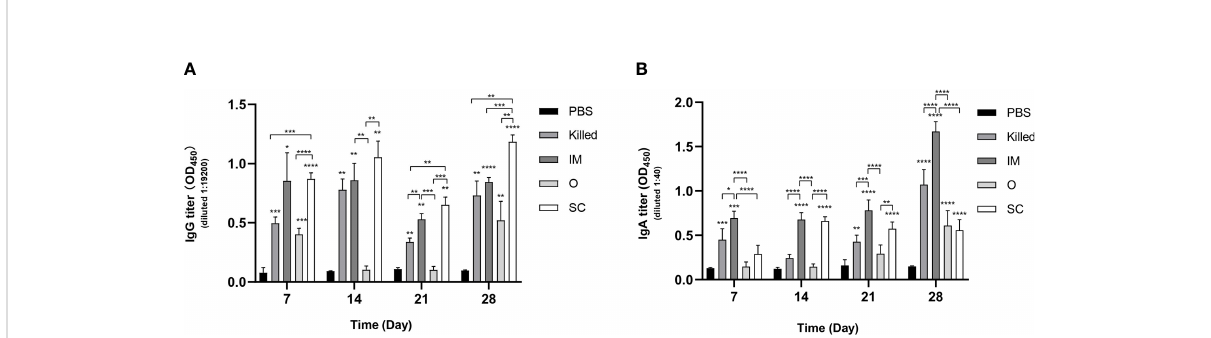
FIGURE 2 Speci fi c IgG and IgA antibodies in mice immunized by E.coli CE9 ghosts. Speci fi c antibody IgG levels in serum (A) and IgA level in intestinal lavage fl uid (B) at 7, 14, 21 and 28 days after immunization. Signi fi cance was analyzed using 2-way ANOVA and Tukey ’ s multiple comparisons test. *p<0.05,**p<0.01,***p<0.001,